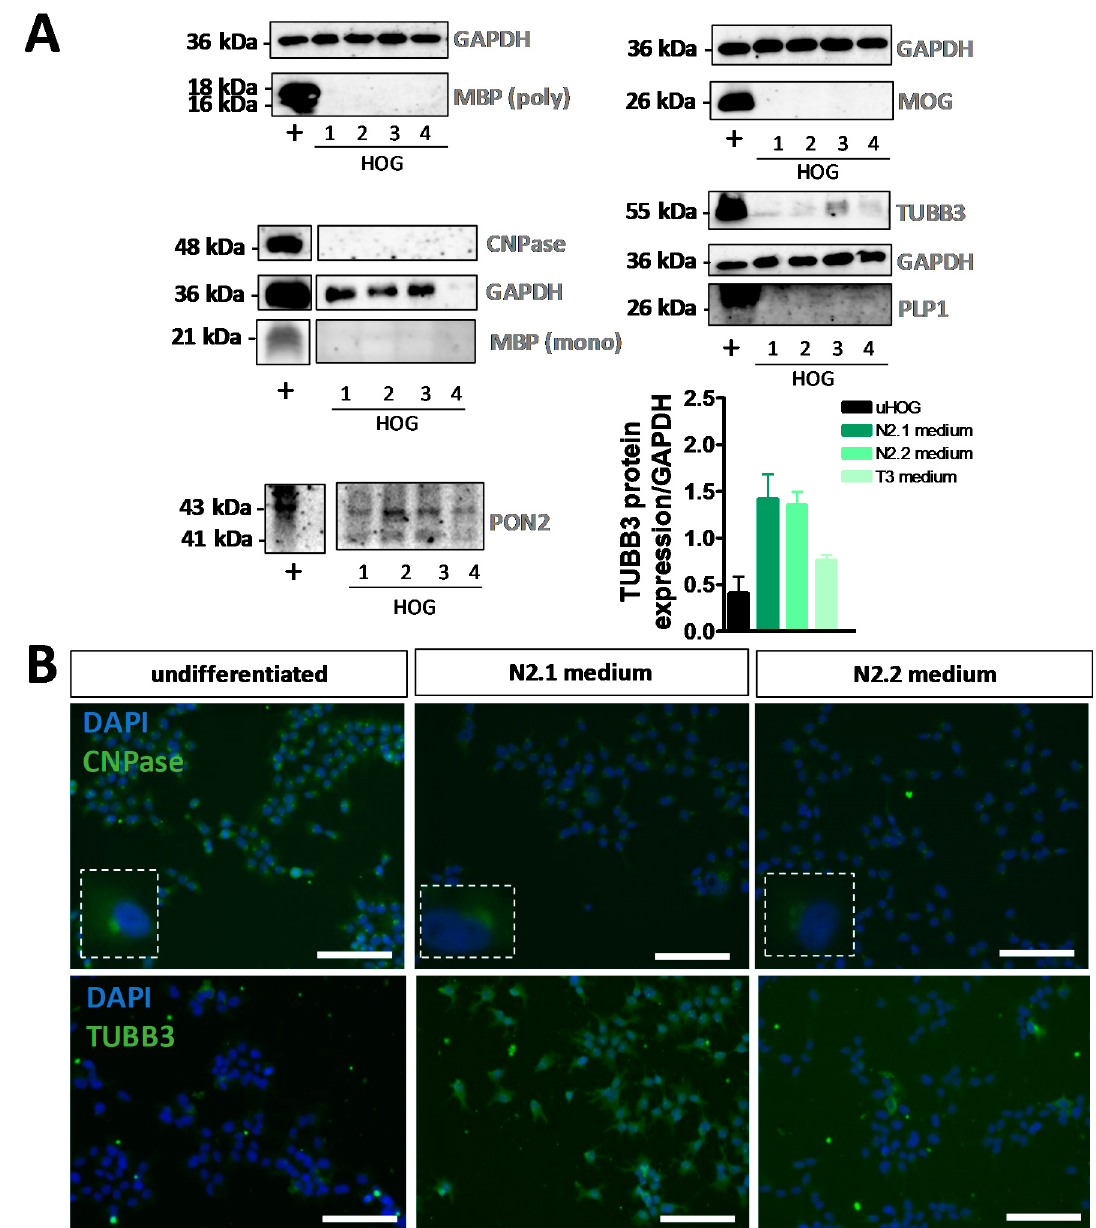
Figure 2. Analysis of protein expression in undifferentiated and differentiated HOG cells. ( A ) Western blot analyses of myelin basic protein (MBP) (polyclonal), myelin-oligodendrocyte glycoprotein (MOG), CNPase, MBP (monoclonal), class III β -tubulin (TUBB3), proteolipid protein 1 (PLP1) and paraoxonase 2 (PON2) in (+) human motor cortex, (1) undifferentiated HOG cells, (2) differentiated HOG cells following incubation in N2.1 medium, (3) N2.2 medium or (4) T3 medium (normalized to GAPDH expression). Western blot analysis was performed for two independent experiments ( n = 2).